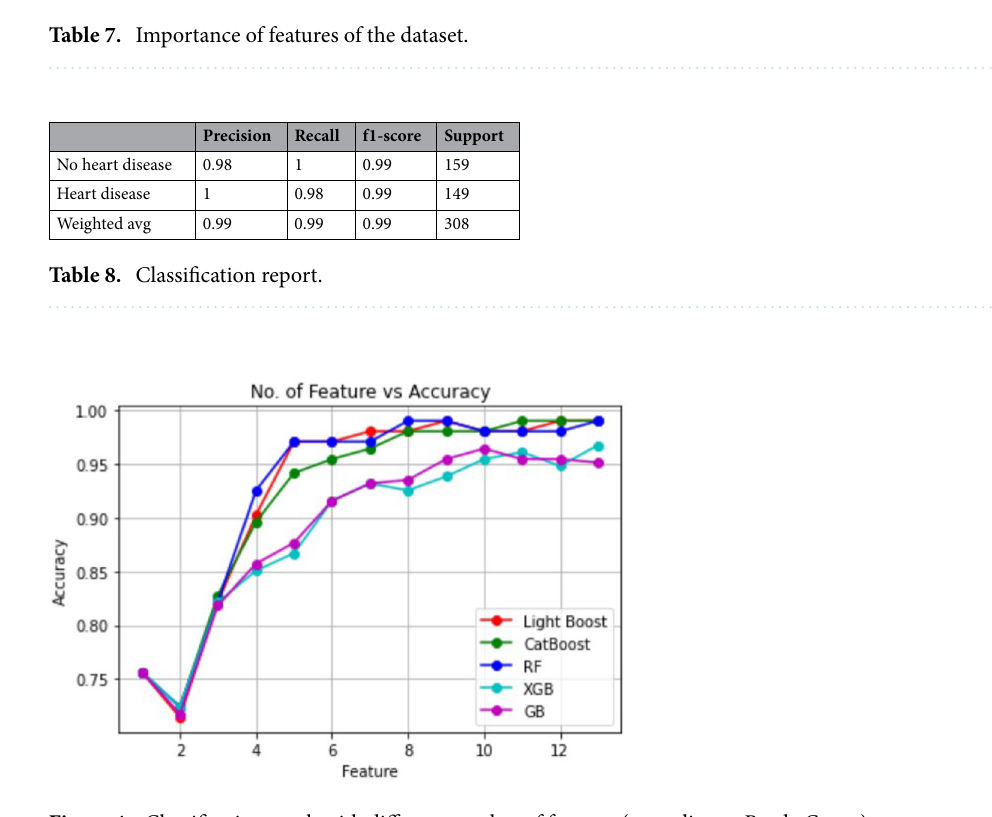
Figure 4. Classification result with different number of features (according to Borda